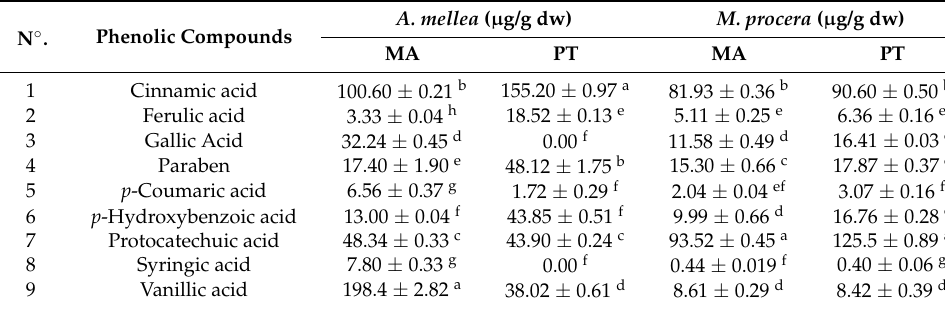
Table 2. Phenolic acids and related compound characterized by LC-MS 1 .